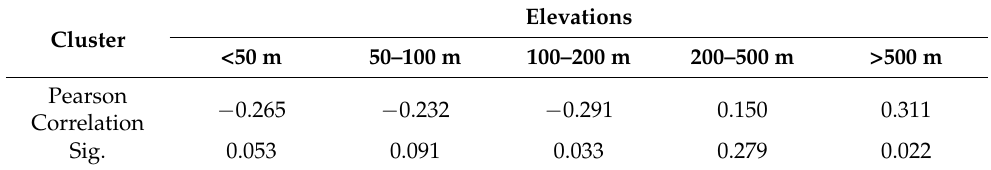
Table 10. Correlations between road restoration clusters and road elevation in Fukushima prefecture.